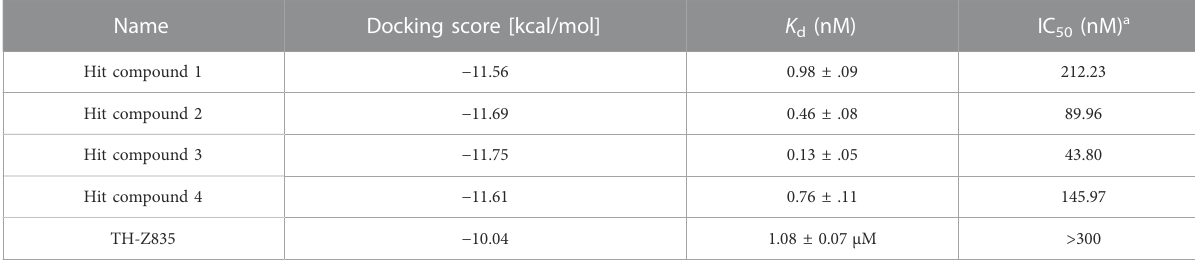
TABLE 2 The docking scores and biological data of four hits.